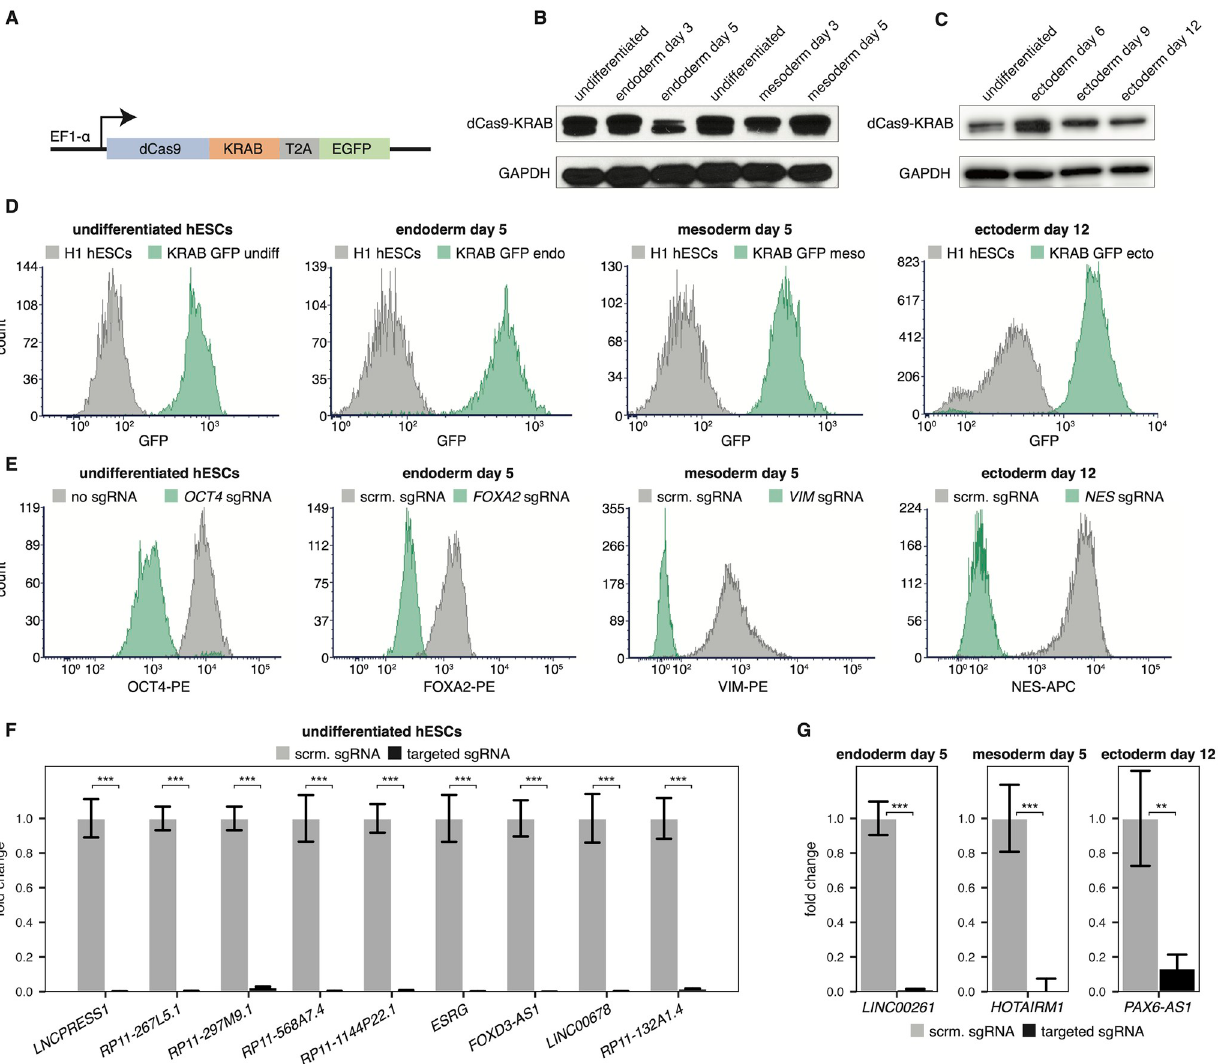
Fig 1. Establishing a CRISPRi cell line that maintains repression during differentiation. (A) Lentiviral GFP construct containing dCas9-KRAB driven by the EF1- α promoter. (B) Western blot of dCas9-KRAB over the course of definitive endoderm and early mesoderm differentiation. (C) Western blot of dCas9-KRAB over the course of neural progenitor cell (ectoderm) differentiation. (D) FACS analysis of GFP expression for undifferentiated and differentiated dCas9-KRAB-GFP line compared to H1 cells. (E) FACS staining of targeted mRNA genes in undifferentiated and differentiated dCas9-KRAB-GFP cells. (F) RT-qPCR expression of targeted lncRNAs in undifferentiated dCas9-KRAB-GFP hESCs. ��� = p < 0.001 by an unpaired t-test. (G) RT-qPCR expression of targeted lncRNAs during endoderm, mesoderm, and ectoderm differentiation in dCas9-KRAB-GFP cells. �� = p < 0.01, ��� = p < 0.001 by an unpaired